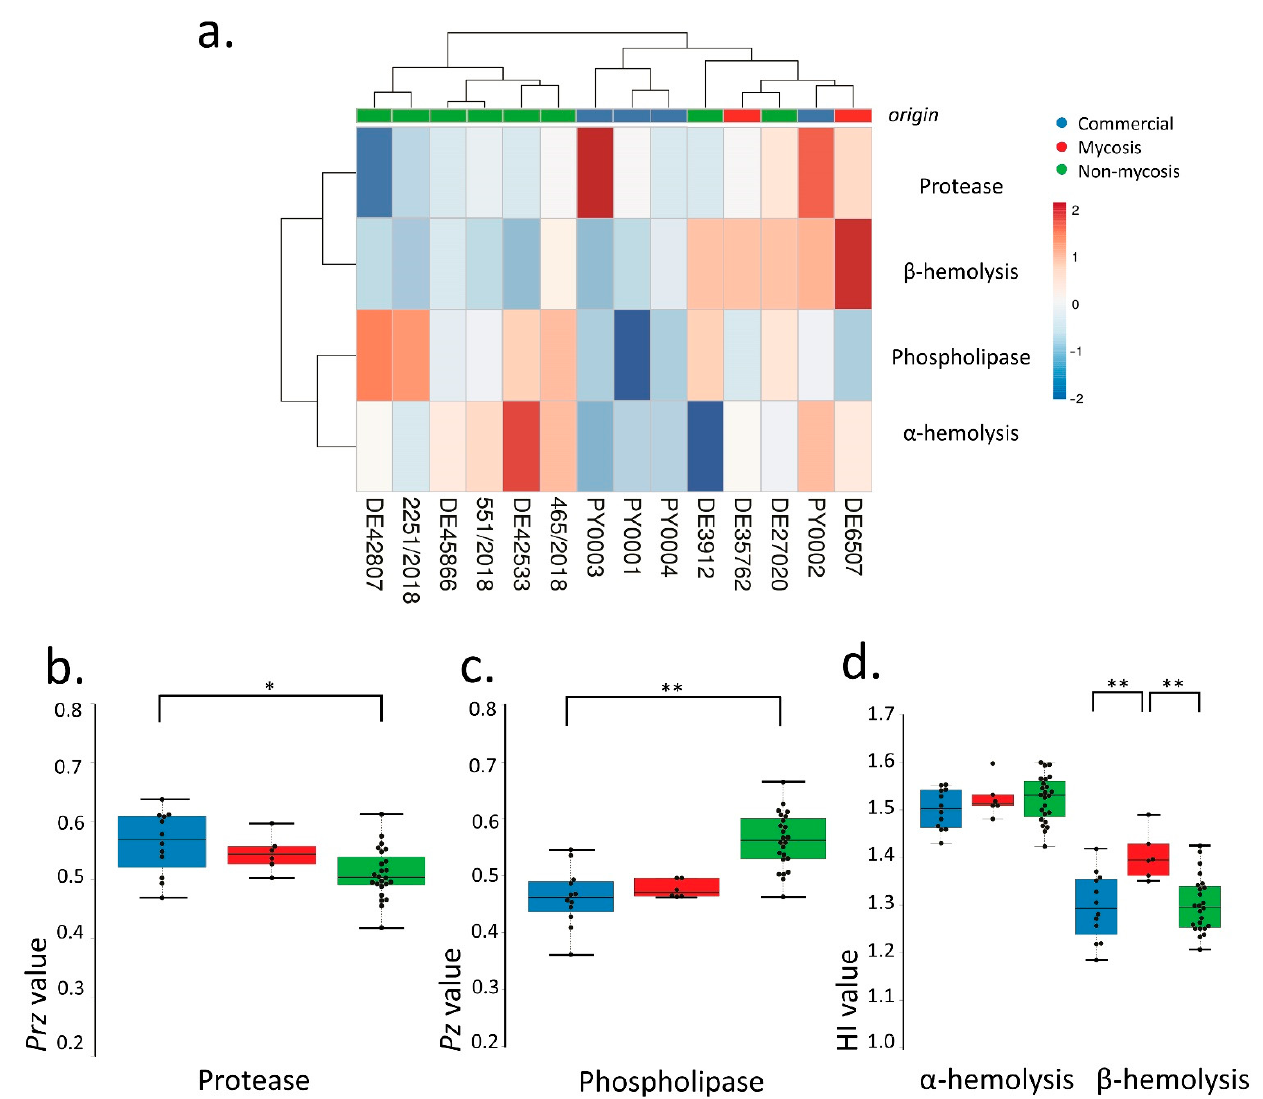
Figure 1. Comparisons of virulence factors (phospholipase and protease production, hemolysis): ( a ) Phenotypic clustering of isolates and heat map representation of results. Isolate groups are color-coded. Isolates are clustered using Euclidean distance and Ward linkage. For hemolysis, values after 2 d ( α -hemolysis) and 3 d ( β -hemolysis) were considered. ( b – d ) Box plot representation of virulence factor measurements for the isolate groups. ( b ) extracellular lipase Pz values; ( c ) extracellular protease Prz values; ( d ) haemolytic indices. Center lines show the medians; box limits indicate the 25th and 75th percentiles; whiskers extend 1.5 times the interquartile range from the 25th and 75th percentiles, outliers and data points are represented by dots. Comparisons with significant differences are marked (*: p < 0.05; **: p < 0.001).